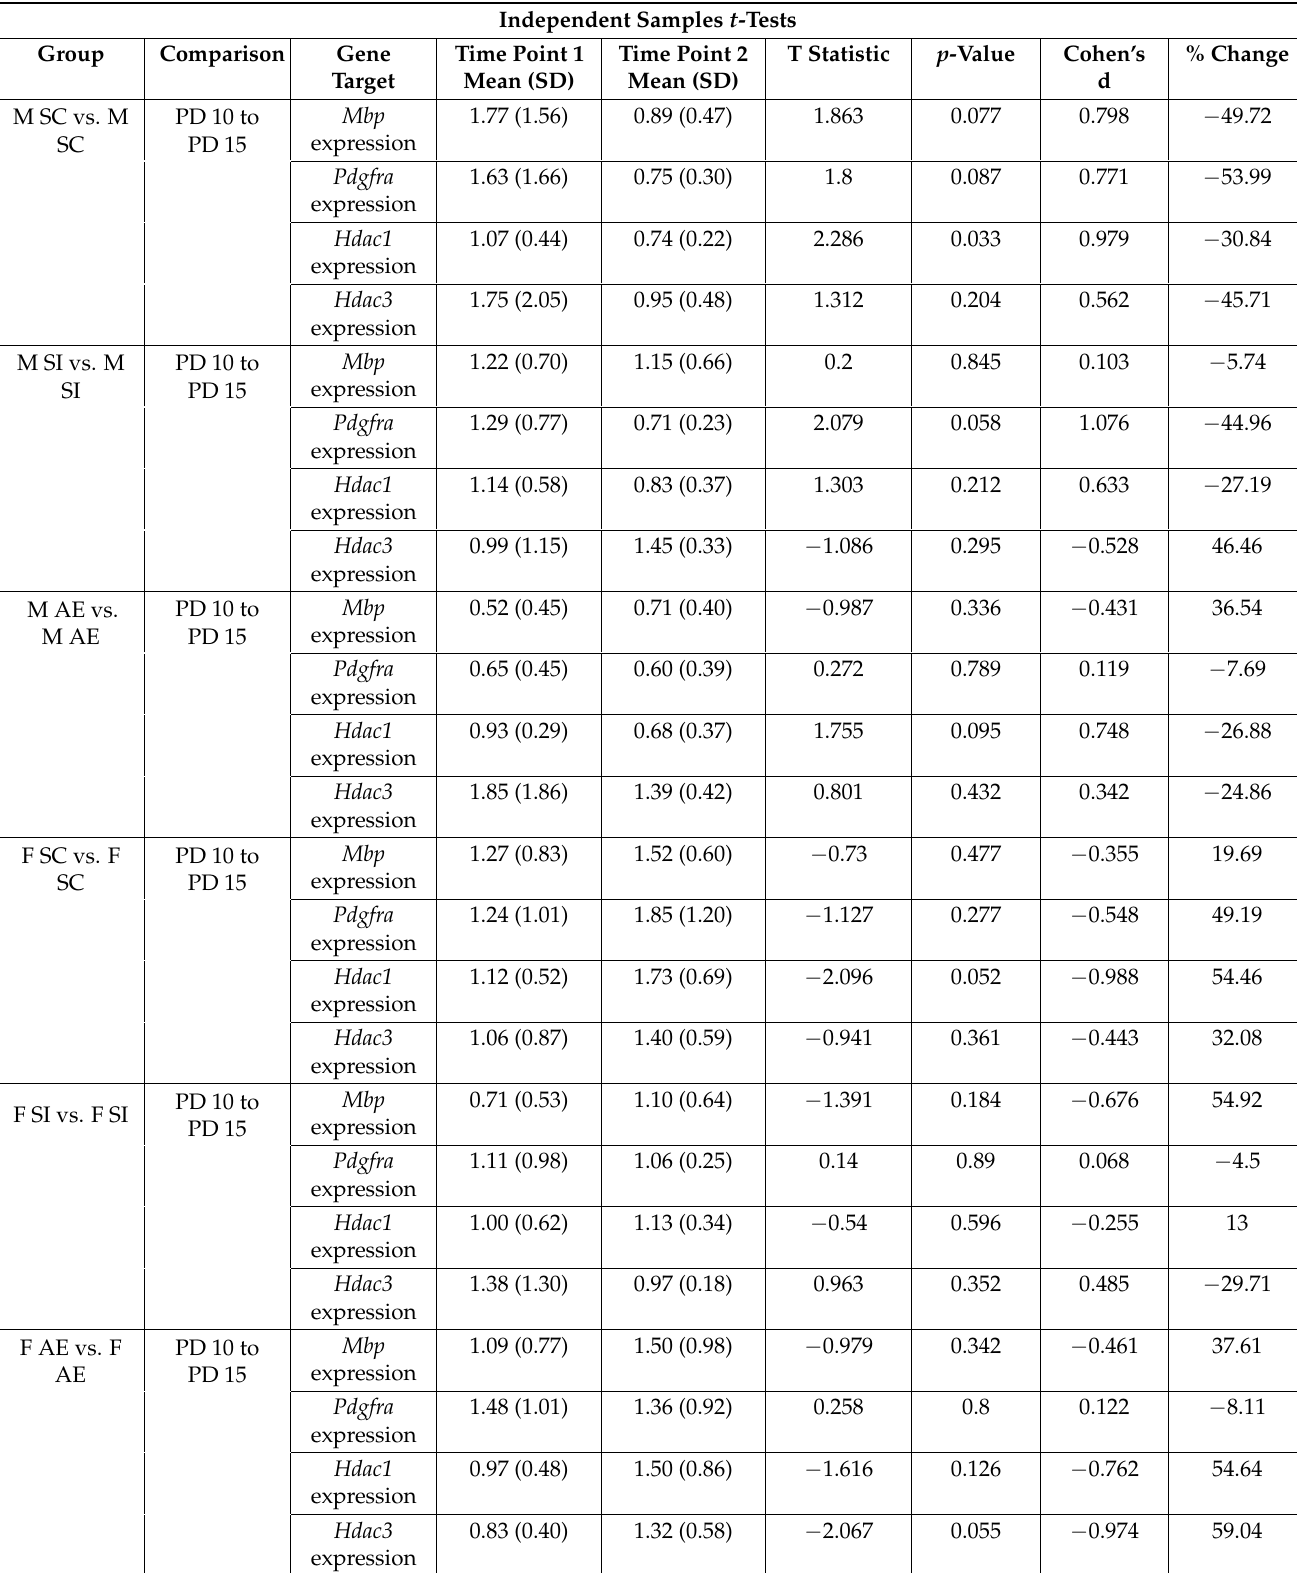
Table 1. Significant results from t -tests comparing measurements of gene expression between time